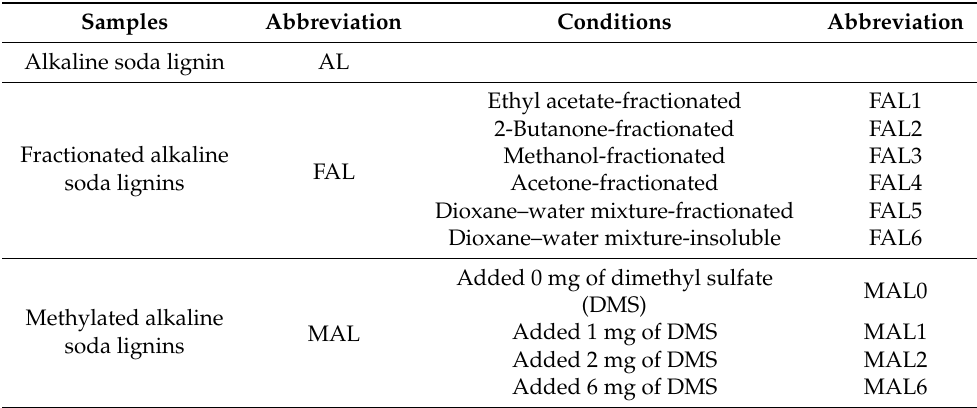
Table 1. List of functionalized alkaline lignin